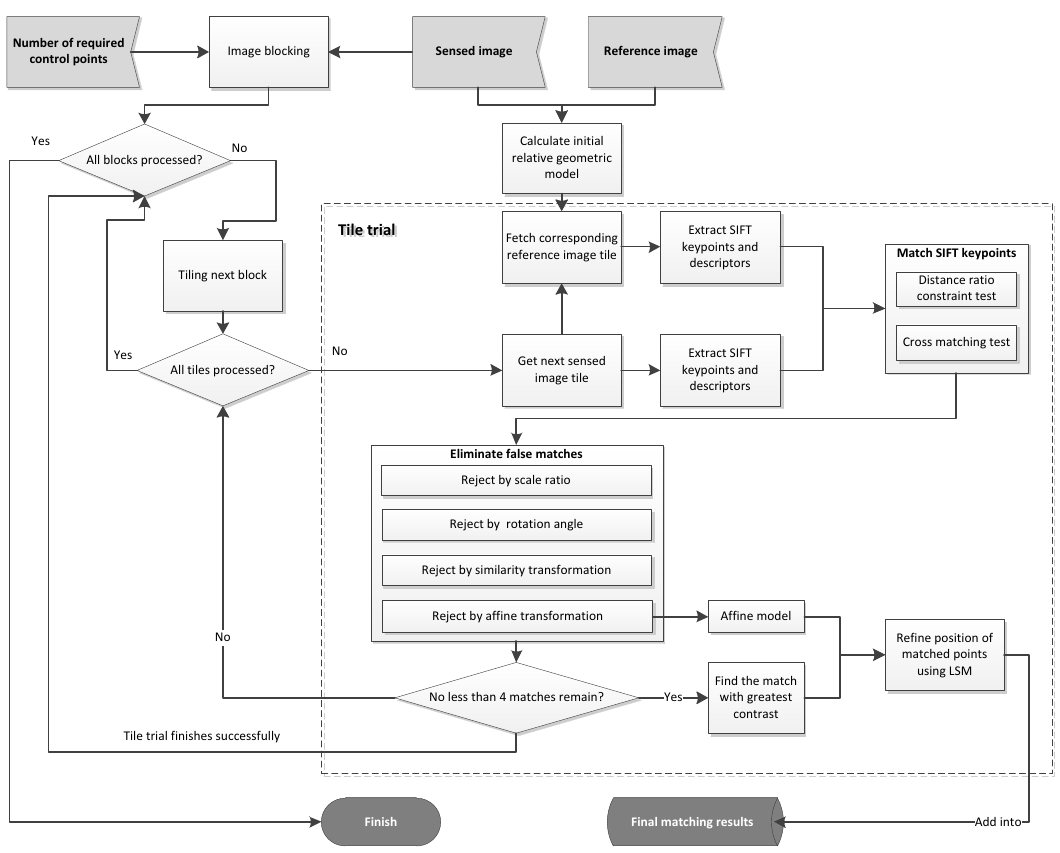
Figure 1. Flowchart of the proposed matching method.